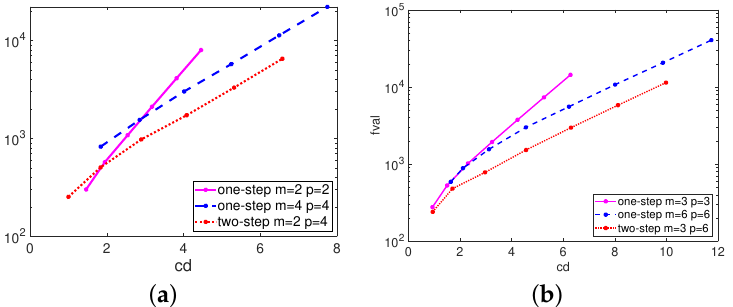
Figure 2. Work-precision diagrams for one- and two-step collocation methods for FDEs, cd is the number of correct digits, and fval is the number of function evaluations. ( a ) One-step methods with m = 2 and m = 4, two-step methods with m = 2; ( b ) one-step methods with m = 3 and m = 6, two step methods with m =